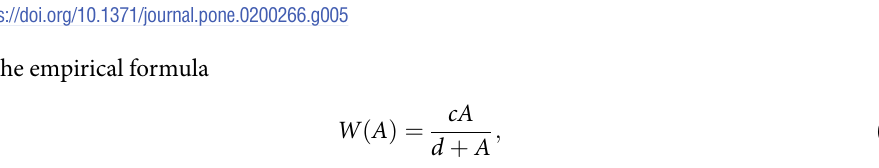
Fig 5. The total flow rates through several lattice graphs as a function of their average vessel radius. The dashed lines are the extrapolation from the actually computed flow rates. The legend indicates the pressure drop Δ P .